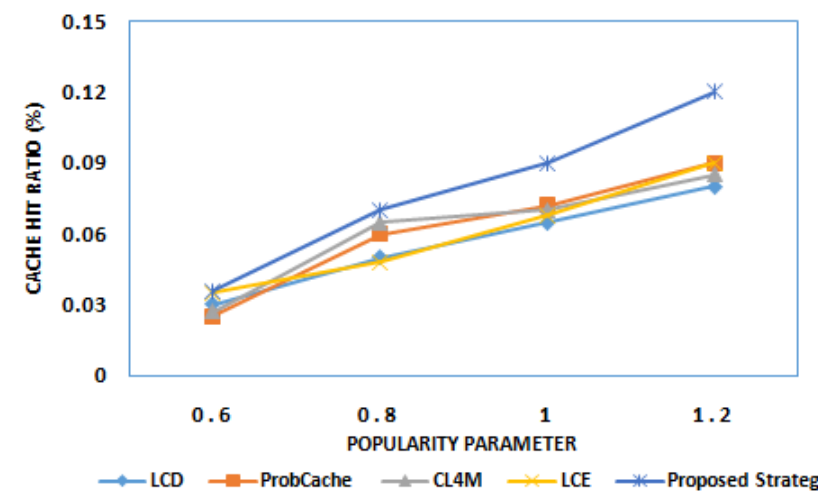
Figure 3. Cache hit ratio for different popularity parameter α